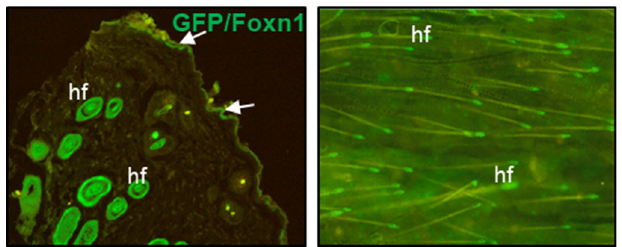
Figure 1. Foxn1 expression in the skin of Foxn1::eGFP mice. hf-hair follicles, arrows indicate Foxn1 positivity in the epidermis.